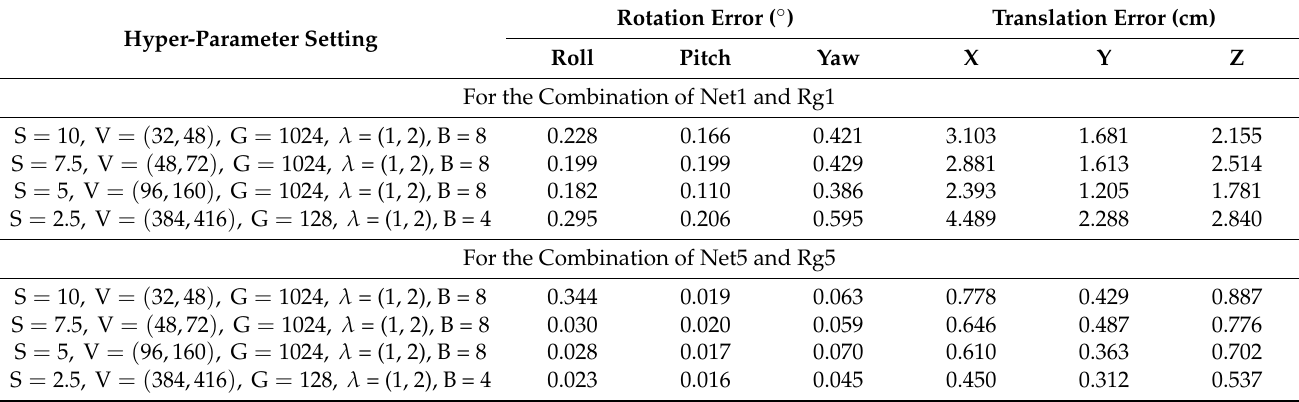
Table 6. Comparison of calibration performance according to S on the KITTI dataset.